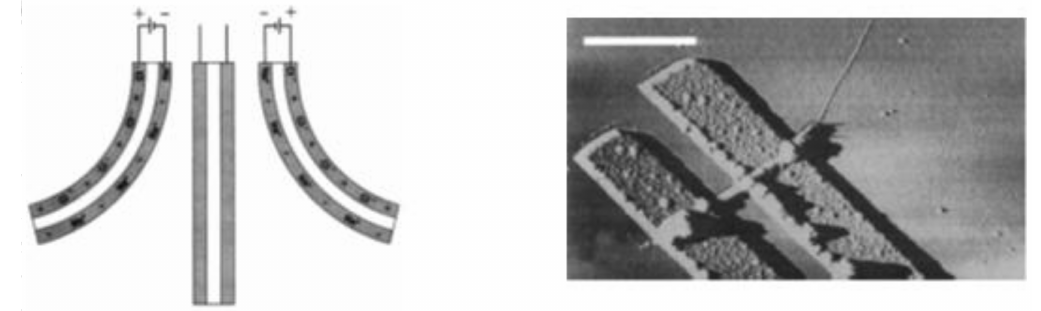
Figure 4. Examples of actuators based on pristine carbon nanotubes (CNTs), ( left ) from by Baughman et al. [54], ( right ) from Roth et al.